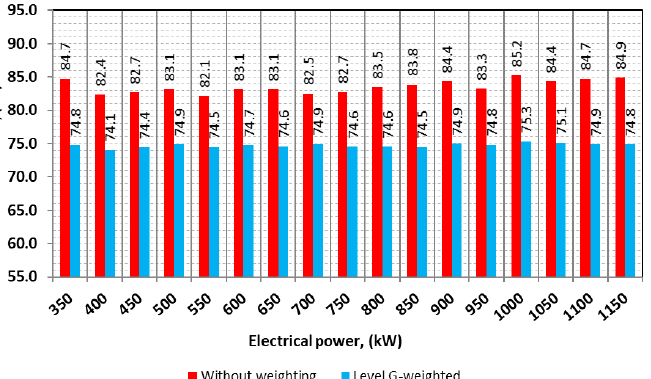
Figure 17. Variations in noise level in the function of volume of electricity delivered to the power system by T1 turbine.